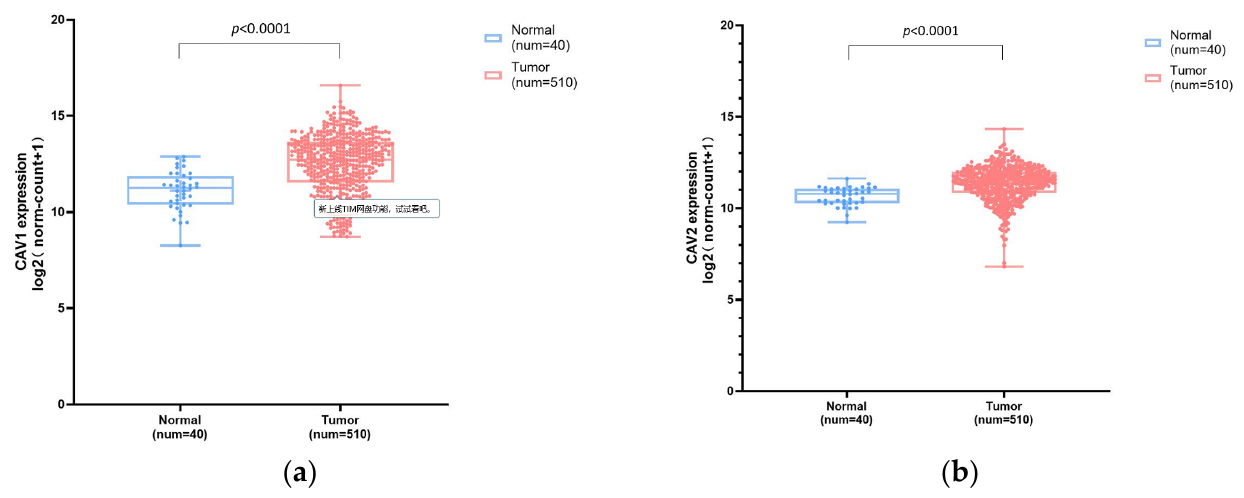
Figure 2. Comparison of mRNA expression levels of CAV1 and CAV2 between HNSC and normal tissues. Box plot chart (( a ), mean ± SD: Normal: 11.11 ± 1.02, Tumor: 12.51 ± 1.53; ( b ), mean ± SD: Normal: 10.65 ± 0.50, Tumor: 11.35 ± 0.95) showing the expression levels of CAV1 and CAV2 in HNSC and their adjacent normal